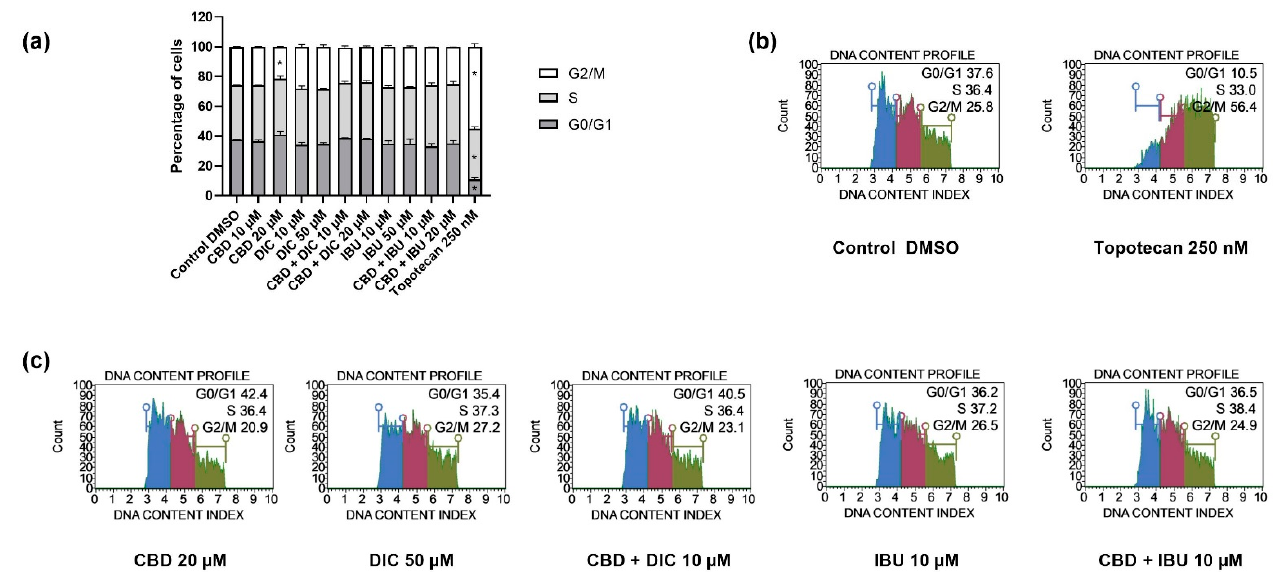
Figure 4. The impact of the analyzed compounds (CBD, DIC, IBU) and their equimolar combinations (CBD + DIC, as well as CBD + IBU) on the distribution of the cell cycle phases in A431 cells after 24 h treatment ( a ). The percentages of cells in the G1/G0, S and G2/M phases were analyzed by the flow cytometry after staining with propidium iodide and RNase A. The values are shown as the mean ± SEM calculated from two independent experiments. (*) indicates statistically significant differences from the control group for a particular phase, p < 0.05. Histograms of the negative and positive controls of the assay, i.e., DMSO and 250 nM topotecan, respectively, are presented in ( b ), while the representative samples are shown in ( c ).